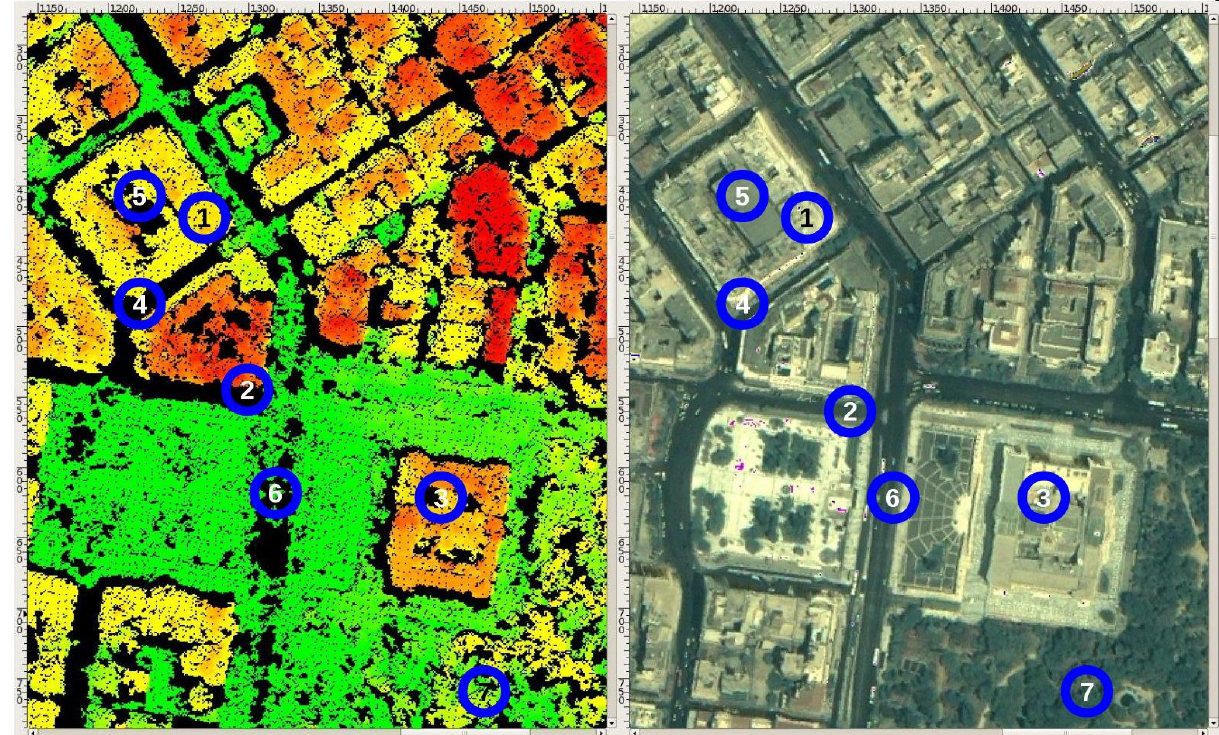
Figure 1: Typical errors occuring in DSMs from dense stereo (left: DSM, right: ortho image, units in meters, urban area near the Akropolis in Athens): 1: warp errors (single 1-pixel-holes), 2: occlusions, 3: court yards, 4: narrow roads, 5: too